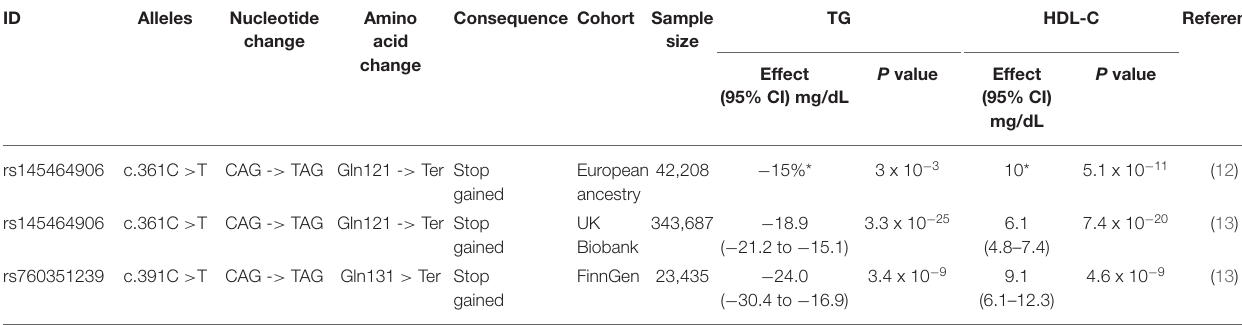
TABLE 1 | ANGPTL8 truncating variants lead to reduced triglyceride but increased HDL-C plasma levels. ID Alleles Nucleotide Amino change acid